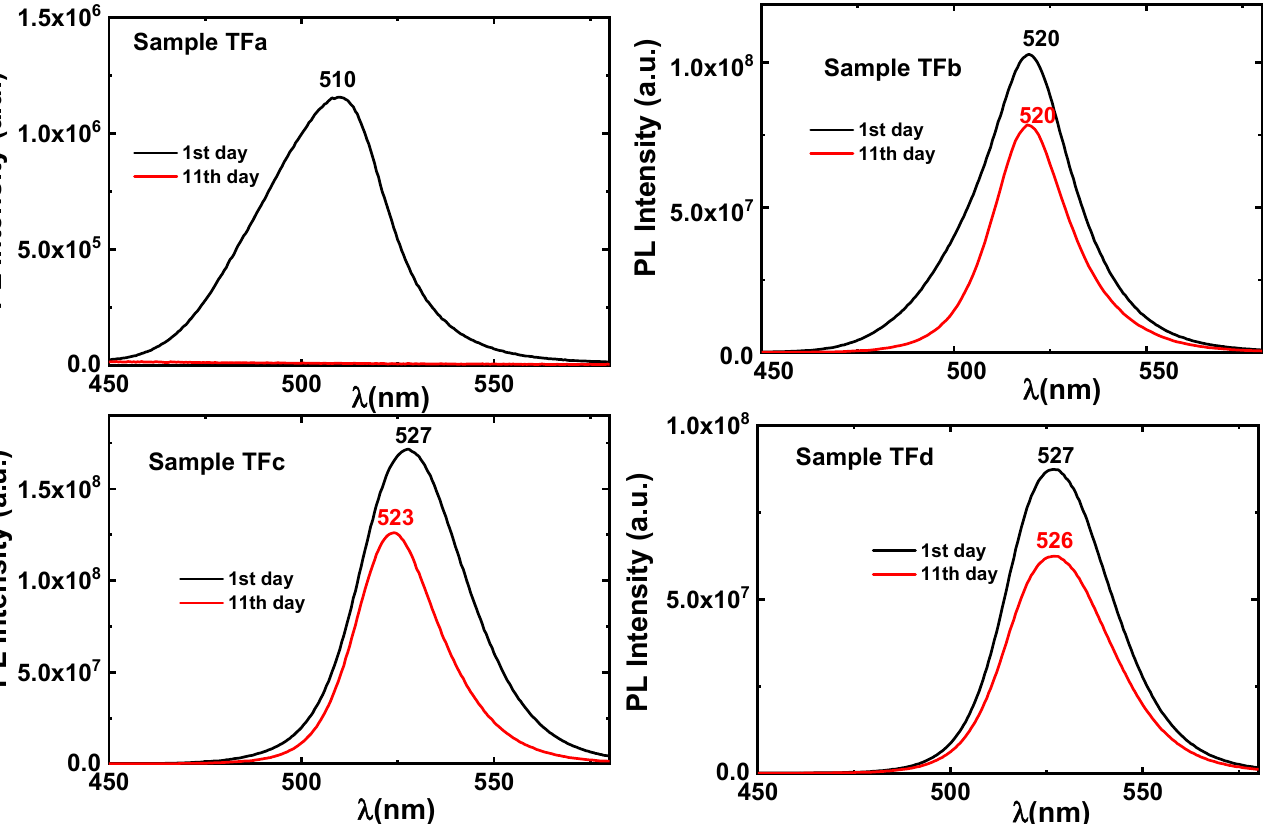
Figure 6. Fluorescence emission spectra of thin-films (TFa), (TFb), (TFc), (TFd) on day 1 (black line) and day 11 (red